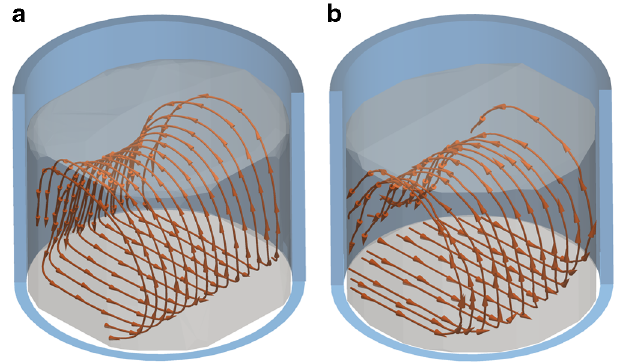
Fig. 5 Results of validating DEM simulations. a shows the exact velocity streamlines, obtained directly by coarse-graining DEM results, whereas b show the rheographic velocity streamlines from the arti fi cial radiographs. The streamlines are shown with orange arrows, with extent of granular material inside cut-away blue cylinder represented by transparent grey